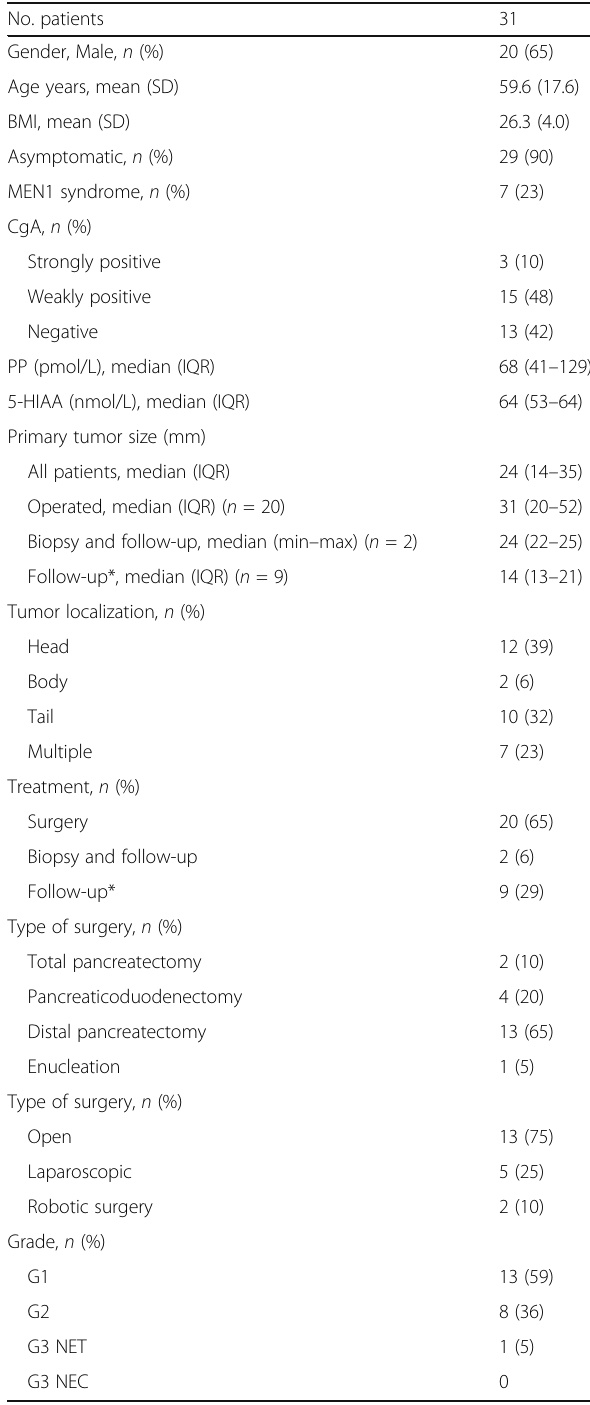
Table 1 Patient characteristics No.